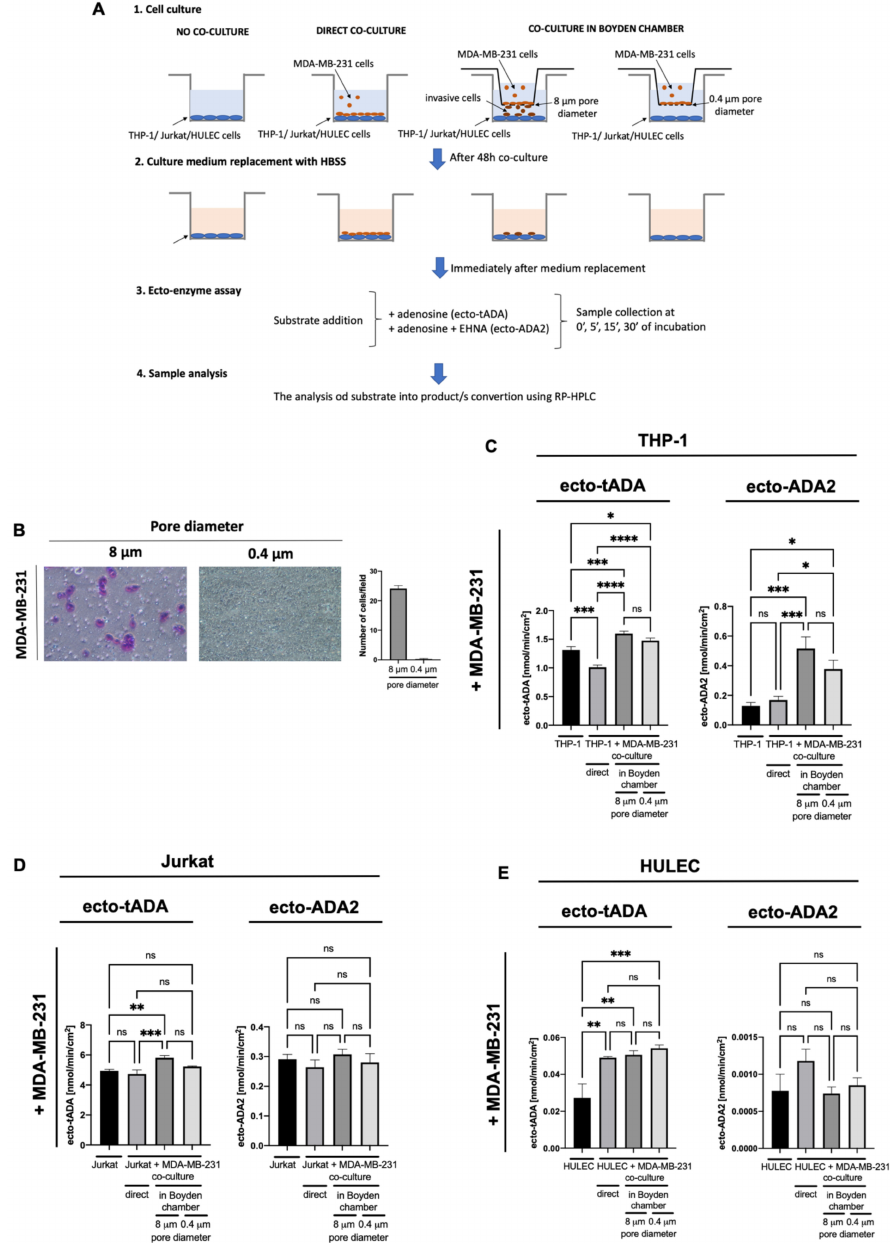
Figure 4. The experimental protocol ( A ), representative images and quantitative analysis of cells migrated via Boyden chambers stained with crystal violet for detection ( B ), total cell surface adenosine deamination rate (ecto-tADA) and in the presence of ADA1 inhibitor EHNA (ecto-ADA2) on human monocyte/macrophages (THP-1, C ), Jurkat cells ( D ), and human microvascular lung endothelial cells (HULEC, E ) after co-culture with human triple negative breast cancer cells (MDA-MB-231 cell line). Results are shown as mean ± SEM, n = 6 − 9, * p < 0.05, ** p < 0.01, *** p < 0.001, **** p < 0.0001 by unpaired t -test ( B ), Kruskal-Wallis test followed by Dunn’s post hoc test ( C ), and one-way ANOVA followed by Holm-Sidak post hoc test ( D , E